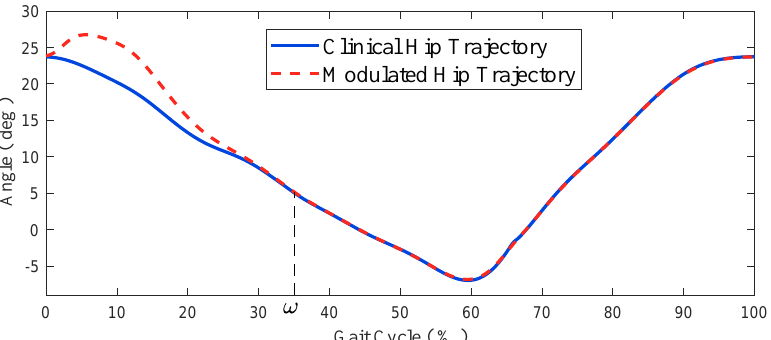
Figure 6. The typical clinical hip trajectory and modulated hip trajectory. Stabilization of the torso by compensation of the hip trajectory after feet strikes.